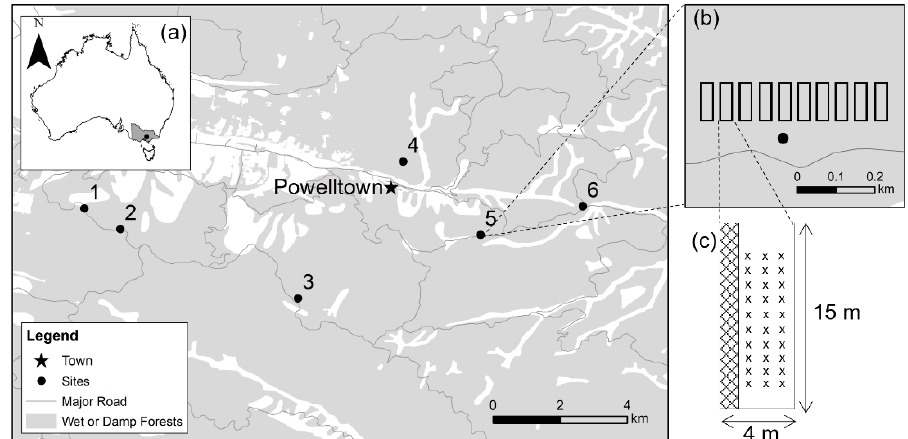
Figure 1. ( a ) The location of study sites in the Central Highlands, Victoria, Australia; ( b ) 10 plots at each site and location of the in-forest weather station (black dot); ( c ) pattern of gridded ignitions within a plot marked by ‘x’; hashed area shows location where litter samples for laboratory experi- ments and fuel samples for moisture determination were taken. Sites are as follows: Beenak (1), Fifth Dam (2), Worlleys (3), Bertha (4), Turners (5), and Big Creek (6).